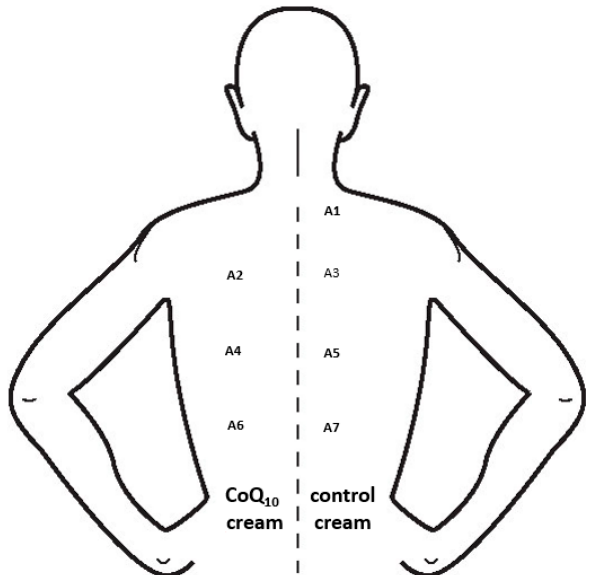
Figure 3. Localization of 12 cm 2 areas of the back for the PAOT-Skin Score ® measurement after topical application of both control and reduced CoQ 10 -enriched creams. Zone A1: T0 corresponding to basal value; zones A2 and A3: measurement after 1 h; zones A4 and A5: measurement after 2 h; zones A6 and A7: measurement after 4